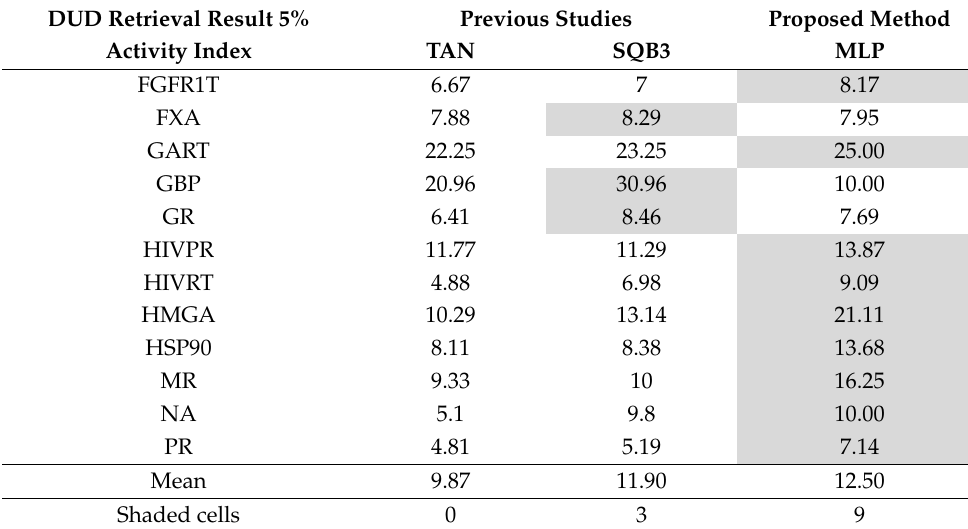
Table 15. Top 5% retrieval results for DUD